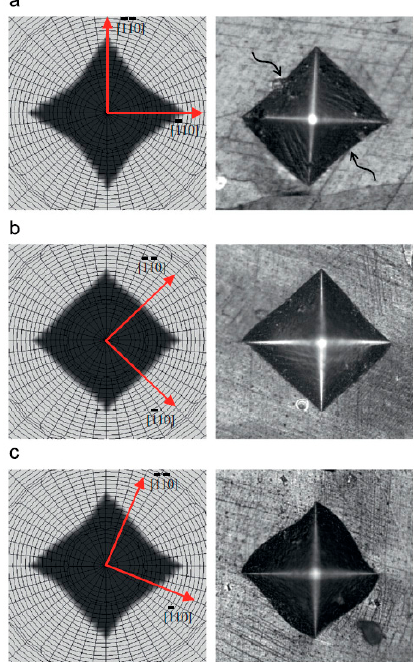
Figure 34. Imprint morphologies for Vickers indentation in the (001) plane for different orientations (rotations) of the tip. ( a ) The slip directions at the surface coincide with the edges of the indenter (arrows indicate development of pincushion effects); ( b ) The slip directions coincide with the sides of the indenter; ( c ) Intermediate orientation to those described in ( a , b ) [130]. Reproduced with